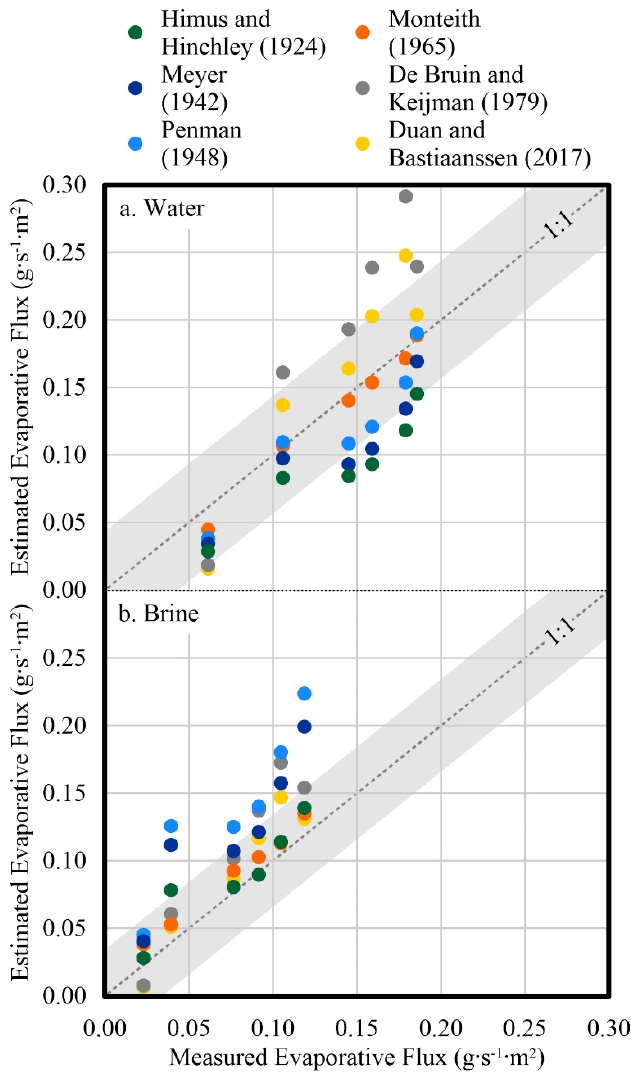
Figure 4. Comparison of estimated and measured evaporative flux for ( a ) distilled water and ( b ) saturated brine.